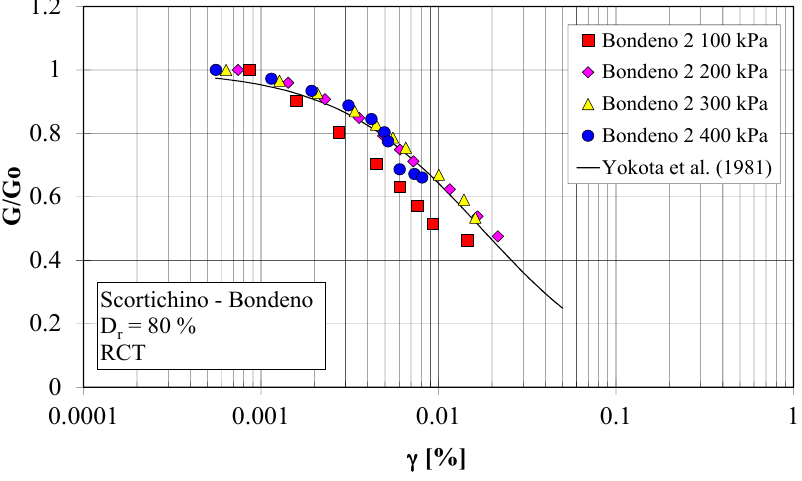
Figure 5. G/G o - γ curves from RCT tests.